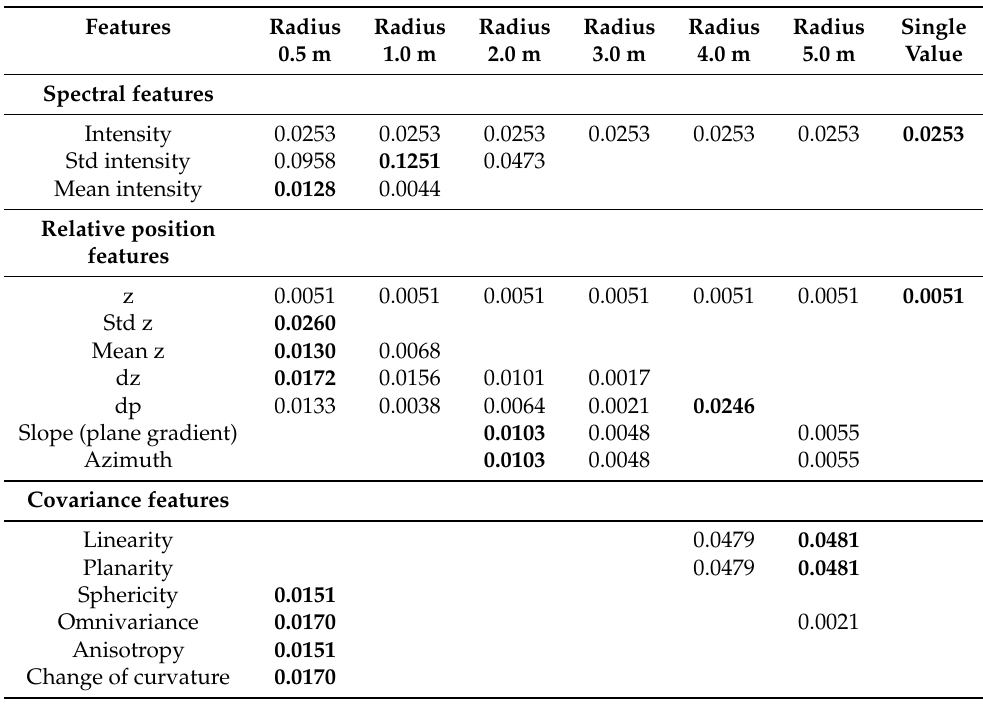
Table 5. Boulder 3 predictors with positive weight calculated from relief-F algorithm.